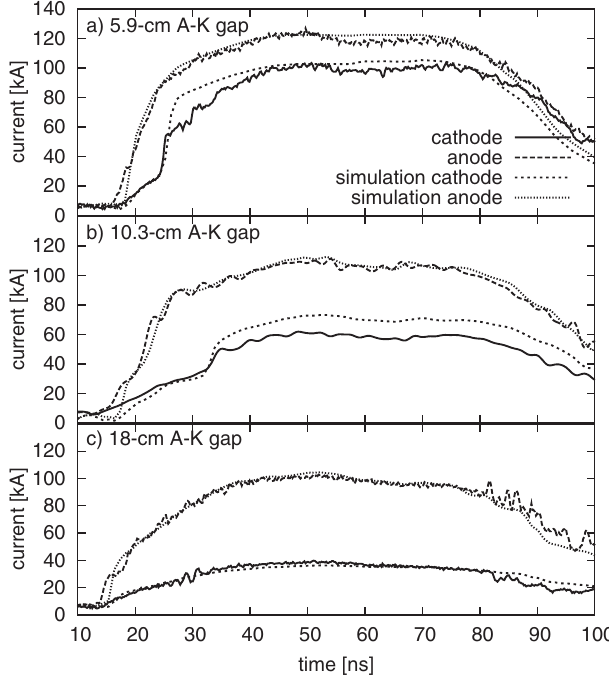
FIG. 6. Simulation results compared to data for the straight MITL with large-area-diode loads with A-K gaps of 5.9, 10.3, and 18.1 cm (RITS-6 shots 14, 17, and 19, respectively). Currents were measured at position G in Fig. 1. The retrapping wave arrives at (cid:1) 25 ns in (a) and (cid:1) 33 ns in (b). No retrapping is apparent in (c) because the load impedance is closely matched to the MITL.